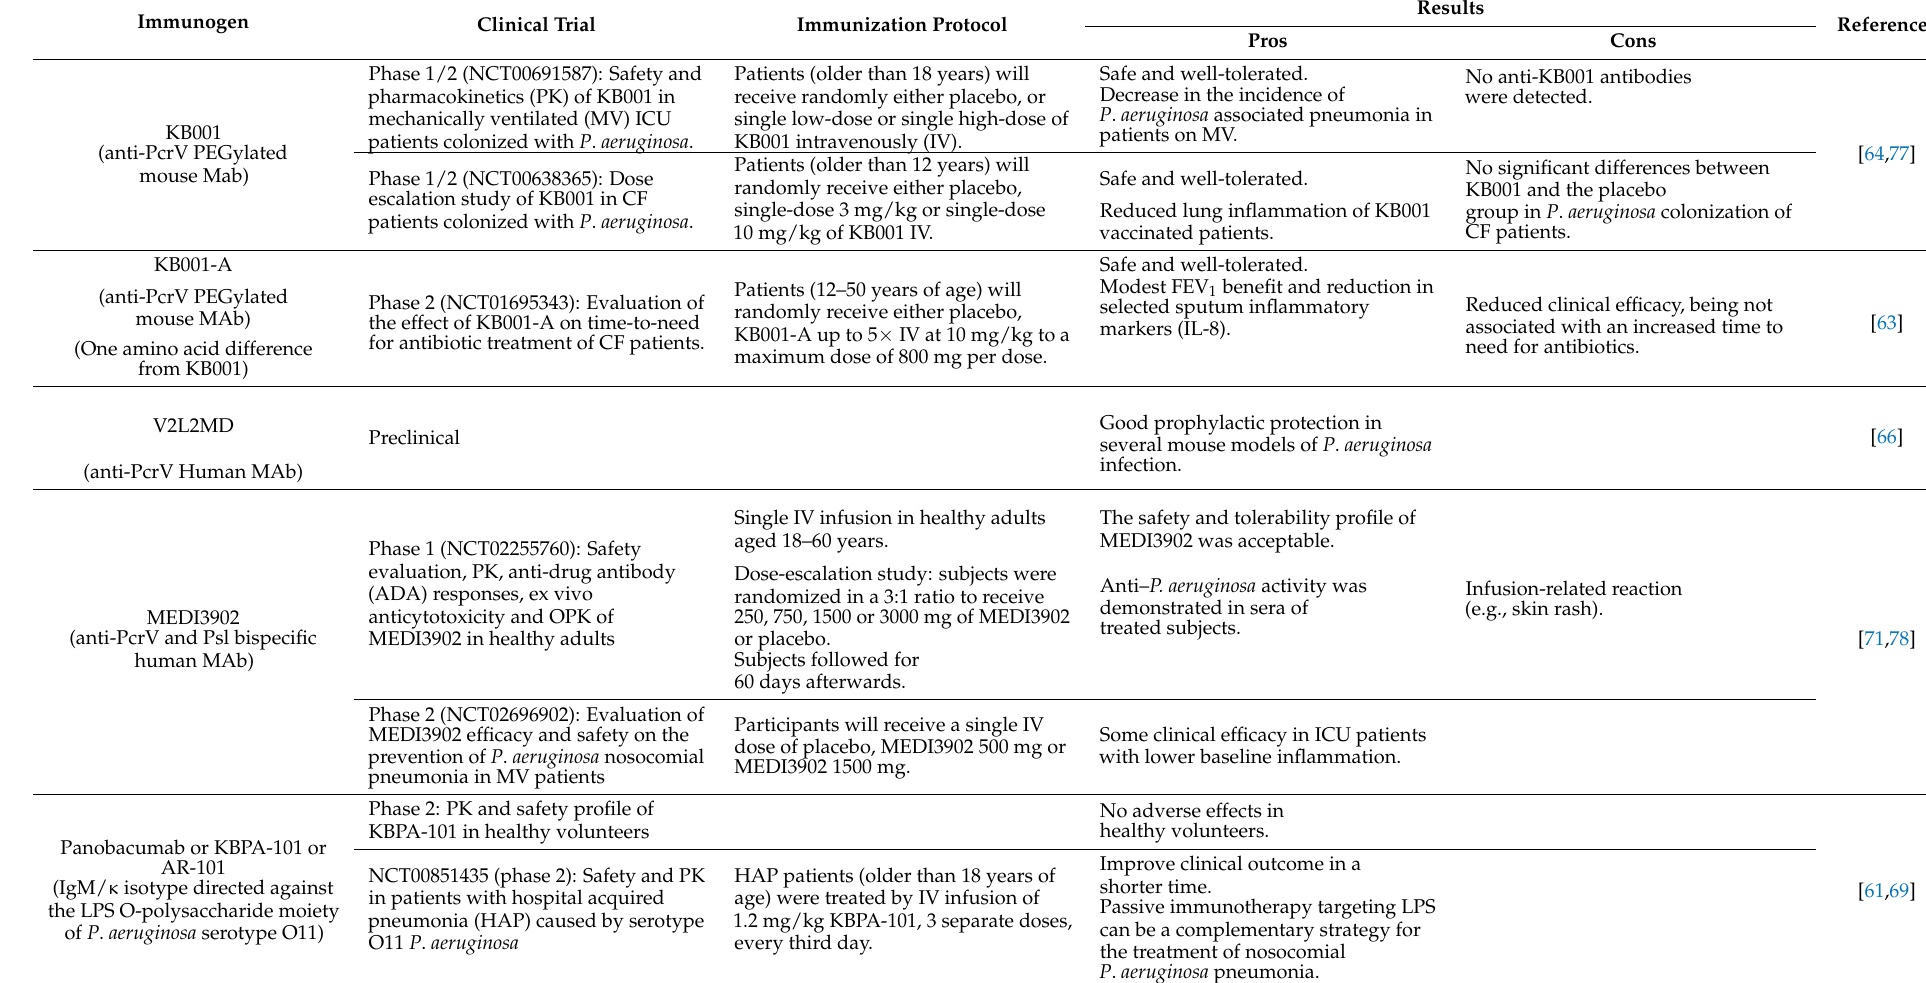
Table 2. Passive immunization preclinical and clinical trials against P . aeruginosa